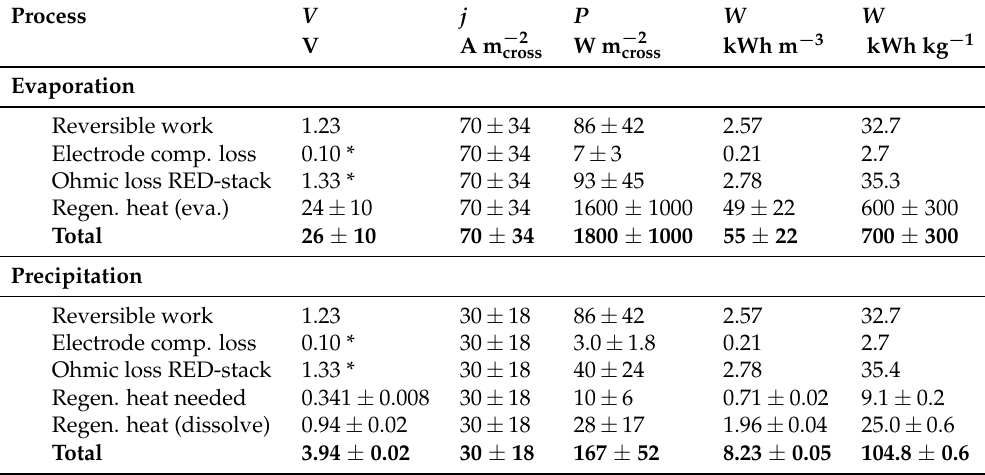
Table 11. Energy needed per volume hydrogen produced from RED using evaporation and precipitation at 40 ◦ C. * Due to the restriction on the ohmic and lumped electrode losses (see Section 3.1), there is no